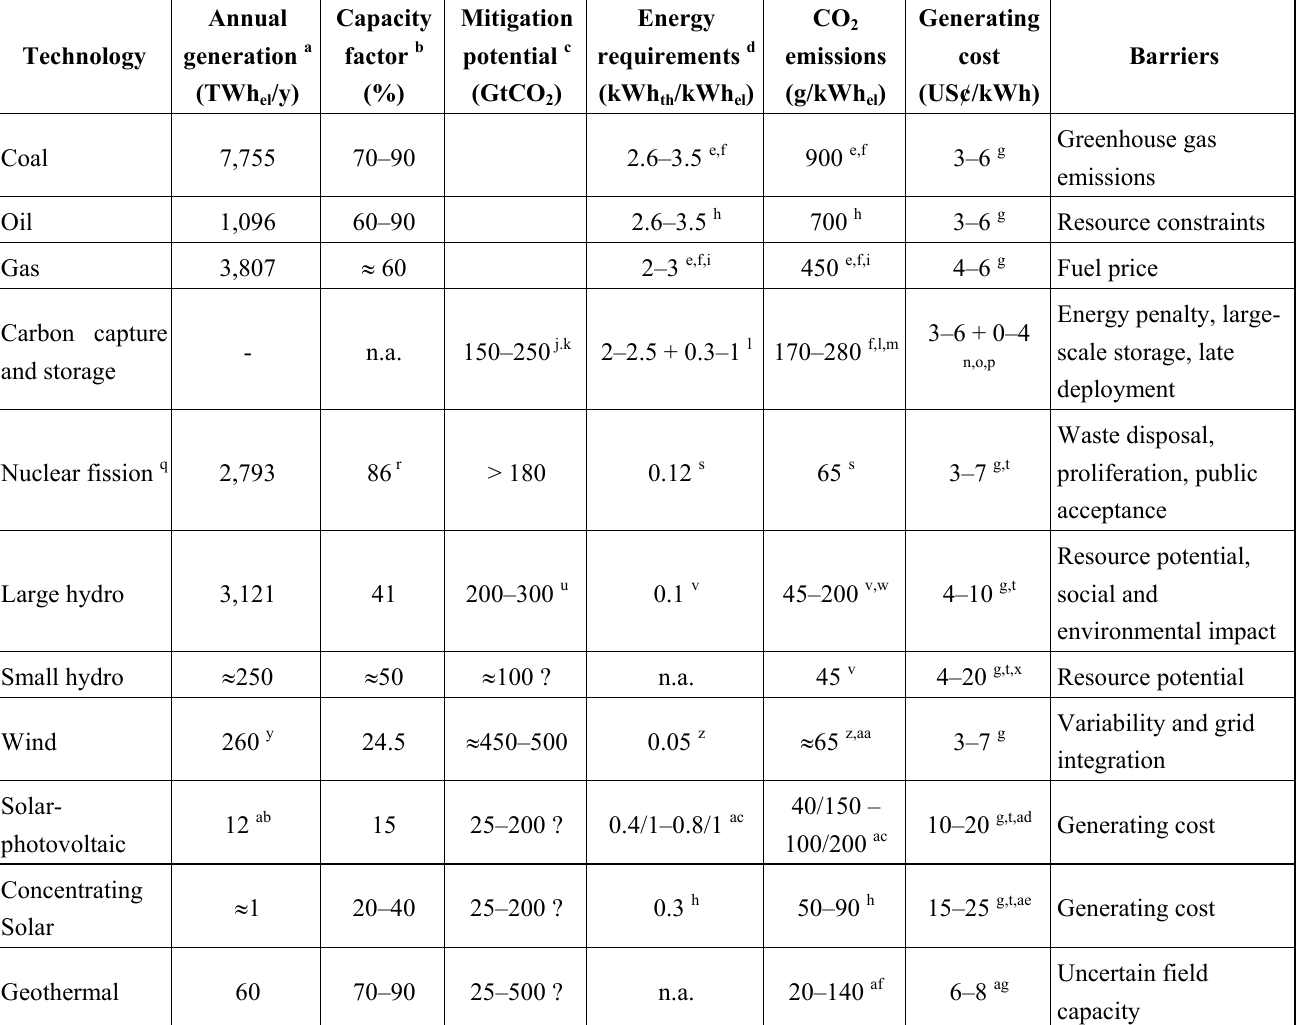
Table 1. Current state of development of electricity-generating technologies (representative